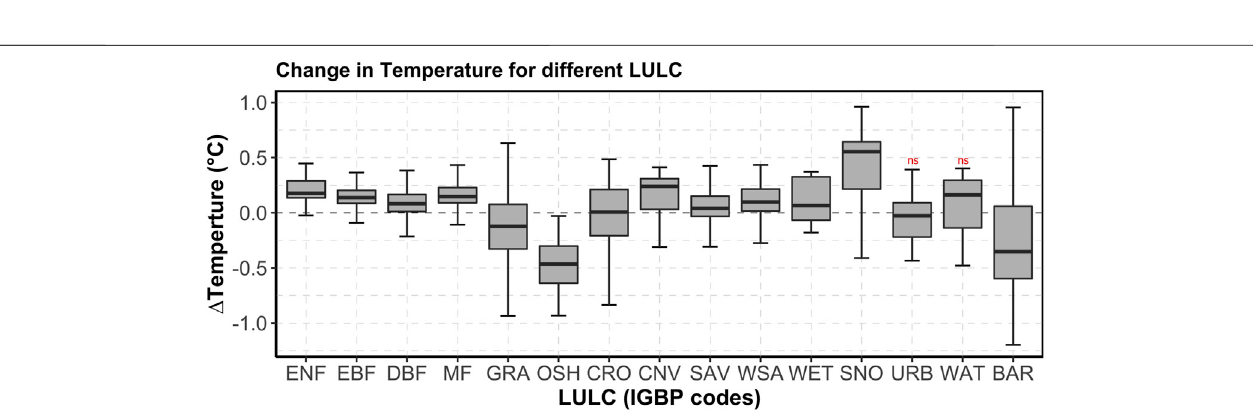
Frontiers in Environmental Science |